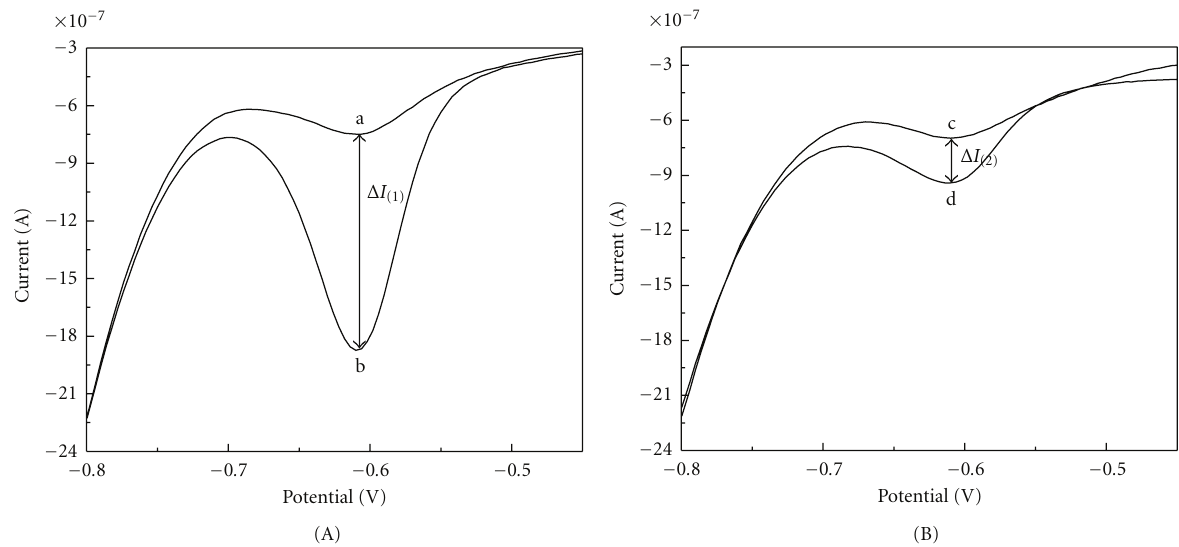
Figure 4: (A) DPV responses obtained for ss-DNA/MAA/AuNPs/Au (a), hybridized with 1.0 × 10 − 10 M complementary DNA (b). (B) DPV responses obtained for the ss-DNA/MAA/Au (c), hybridized with 1.0 × 10 − 10 M complementary DNA (d). Experiment condition: accumulation time of adriamycin: 20min; hybridization time: 25min. DPV parameters were the same as in Figure 2(B).